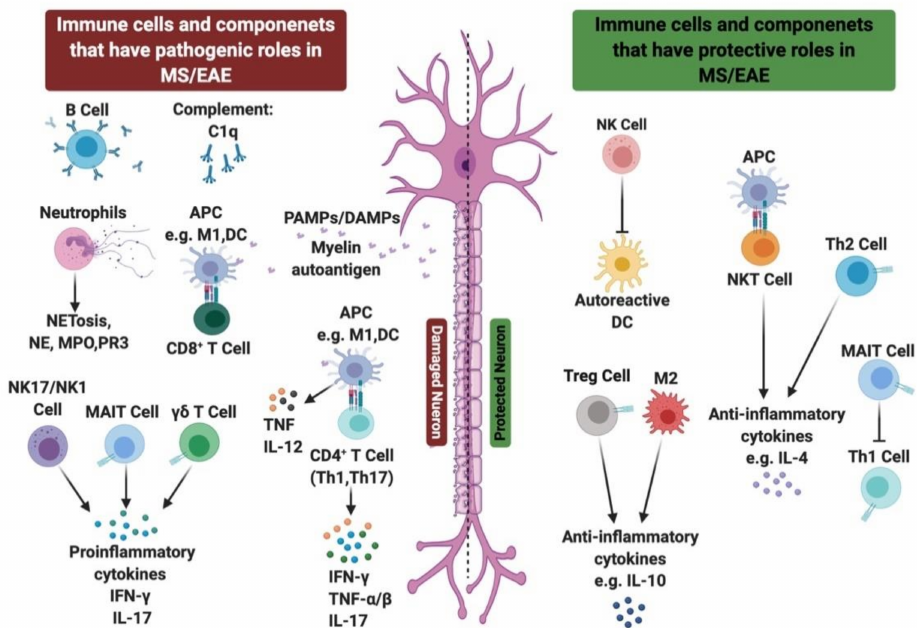
Figure 2. Pathogenic and protective roles of innate and adaptive immune cells and components in multiple sclerosis (MS) and experimental autoimmune encephalomyelitis (EAE). Innate and adaptive immune cells have important pathogenic roles that lead to the development and worsening of MS and EAE. Antigen-presenting cells such as macrophages (in the classical inflammatory